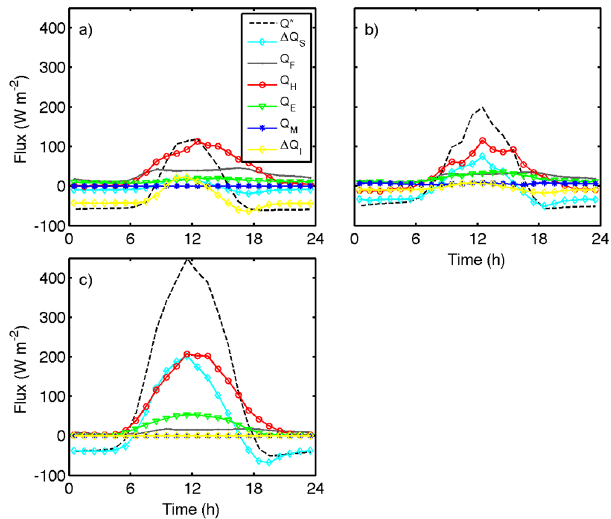
Figure 12. Modelled energy balance at the urban site (Rl) in Mon- treal during (a) cold snow, (b) warm snow and (c) snow-free peri- ods. Q ∗ = net all-wave radiation, 1Q S = heat storage to snow-free surfaces, Q F = anthropogenic heat flux, Q H = sensible heat flux, Q E = latent heat flux, Q M = snowmelt/freezing water related en- ergy flux and 1Q I = heat storage in snow pack.